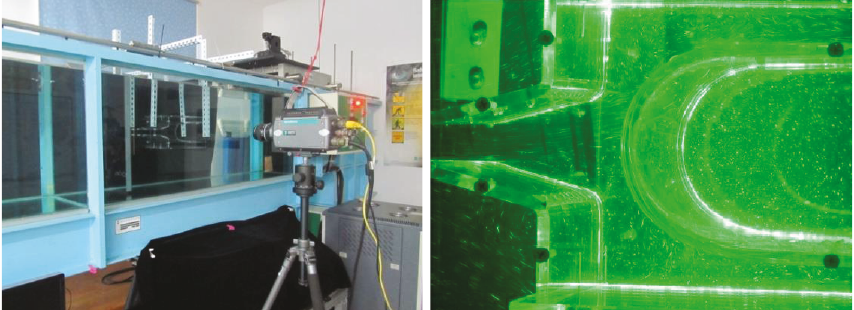
Figure 9: Experimental facility.